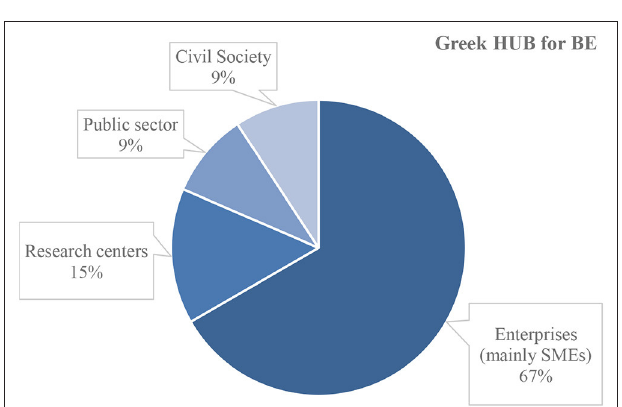
FIGURE 8 | Synthesis of the